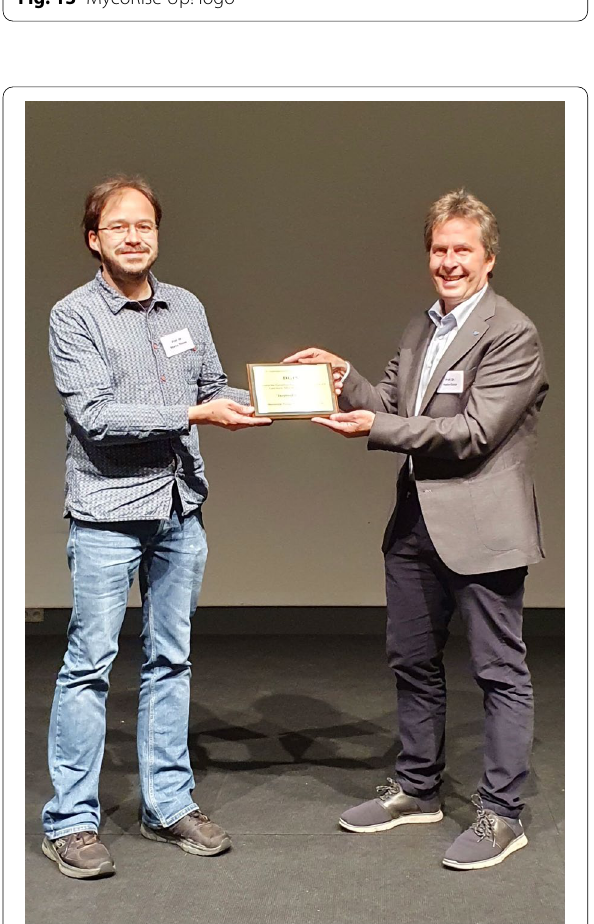
Fig. 14 Marco Thines ( left ), President of the German Mycological Society, receiving a commemorative plate from the Westerdijk Biodiversity Institute presented by Pedro Crous ( right )